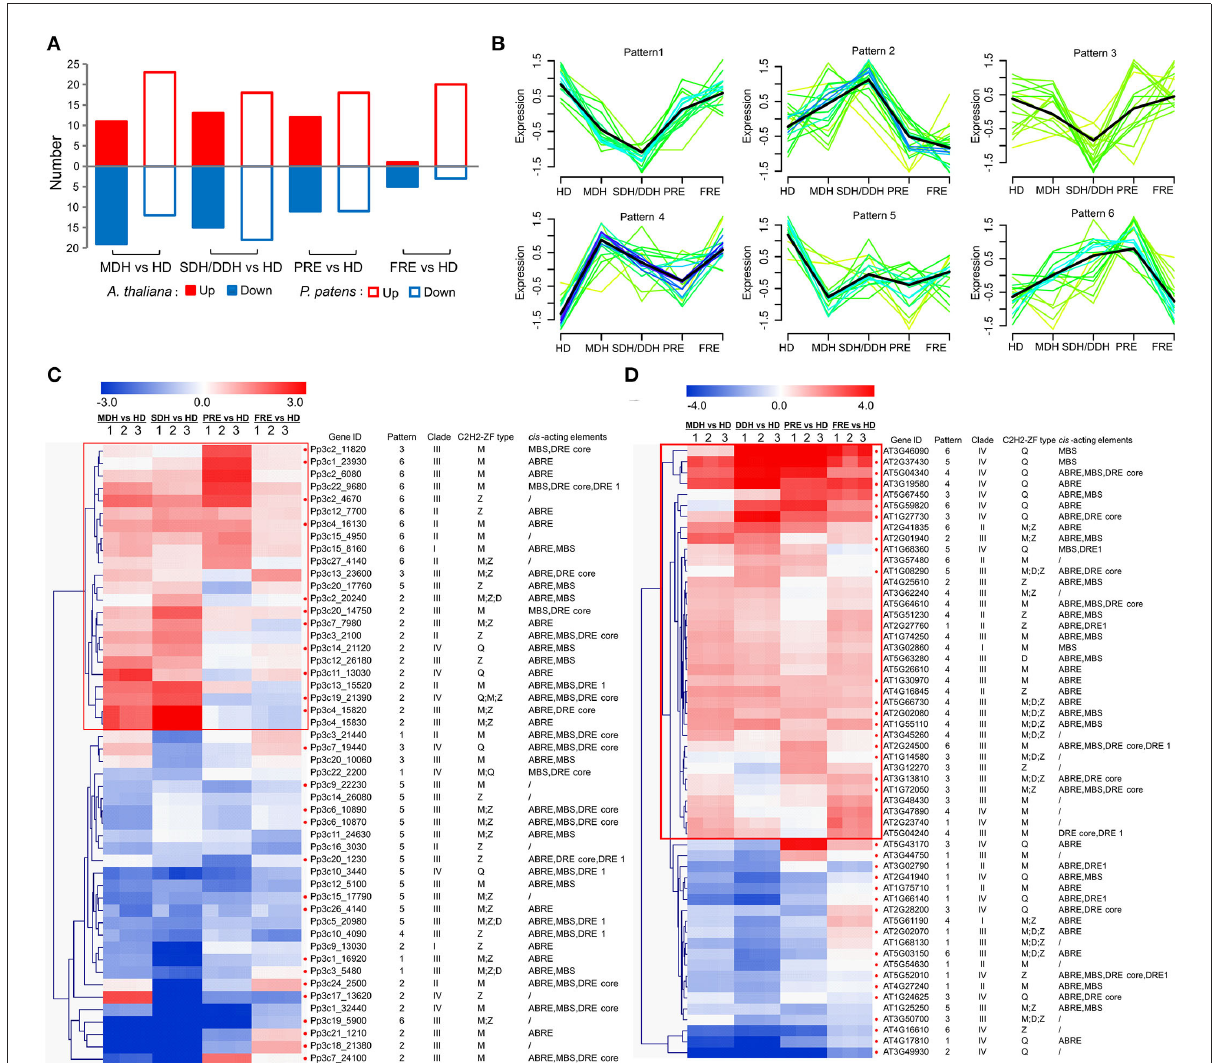
FIGURE5 Profiles of the differentially expressed PpZFPs and AtZFPs in the responses of dehydration and rehydration. (A) All differentially expressed genes and differentially expressed PpZEPs and AtZFPs . (B) Profiles of the differentially expressed AtZEPs . (B) Mfuzz clustering of the differentially expressed PpZEPs and AtZEPs . (C) Integrated profile of the differentially expressed PpZEPs . (D) Integrated profile of the differentially expressed AtZEPs . In the color panels, each horizontal line represents a single gene, and the color of the line indicates the expression level (in a log scale) of the